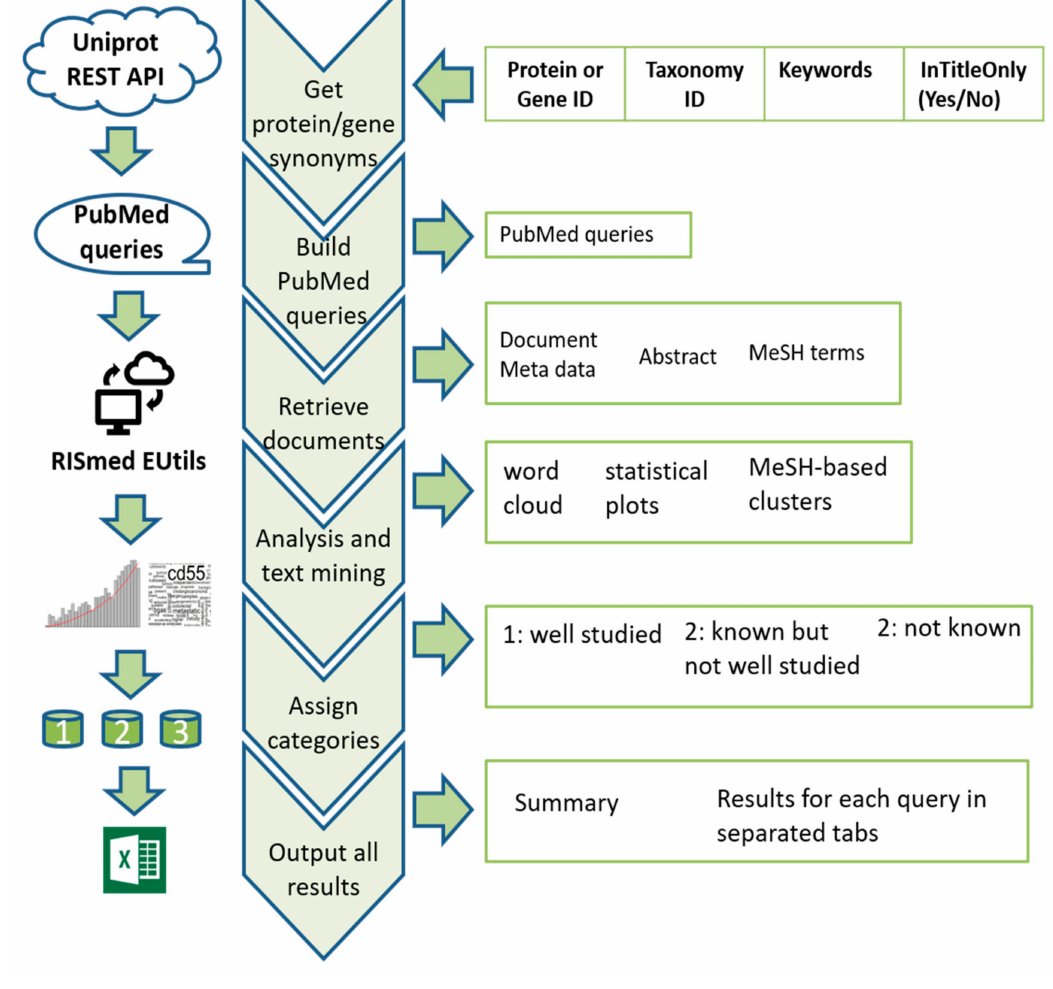
Figure 2. Schematic workflow showing the di ff erent steps the OmixLitMiner tool goes through before generating an output